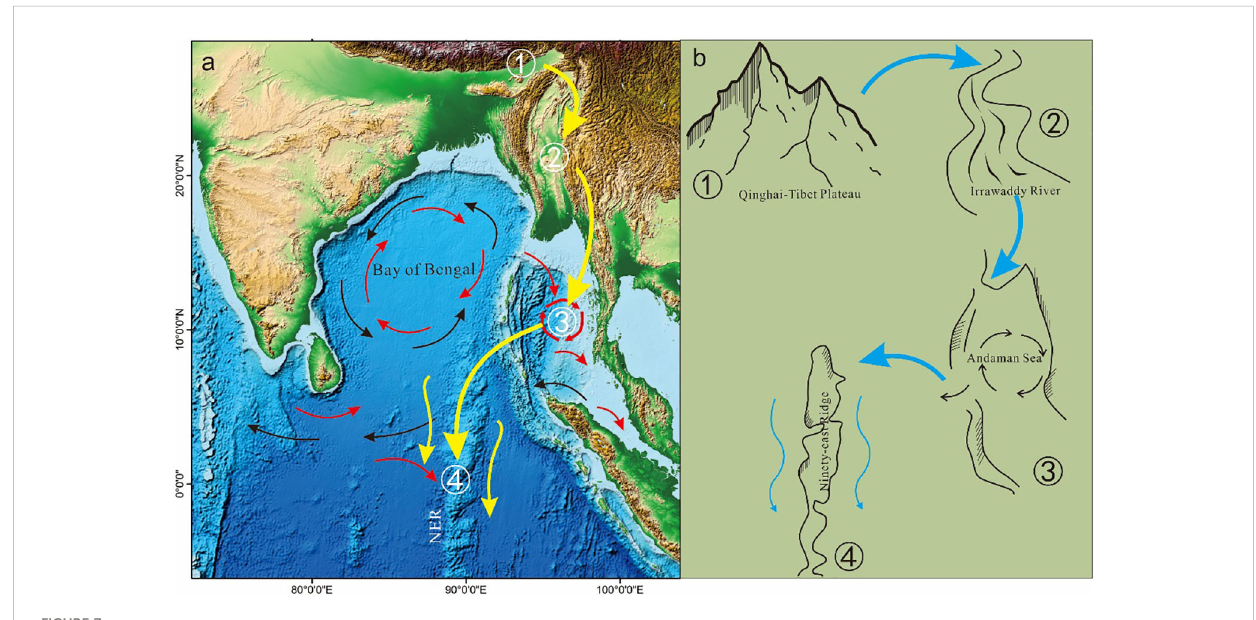
FIGURE 7 Transport path pattern of terrigenous sediments in the NER. (A) and migration model from the Qinghai - Tibet Plateau to the NER (B) . ( A : black arrow indicates winter monsoon, red arrow indicates summer monsoon, yellow arrow indicates transport path, cited by Joussain et al, 2016; A, B : ① - Weathering and denudation of the Qinghai-Tibet Plateau; ② - Material from the Qinghai-Tibet Plateau was transported to the Irrawaddy River; ③ - Material from the Tibetan Plateau drains into Andaman Sea, and then enters monsoon circulation system; ④ - Material from the Tibetan Plateau are transported westward to the northern NER by the monsoon-driven